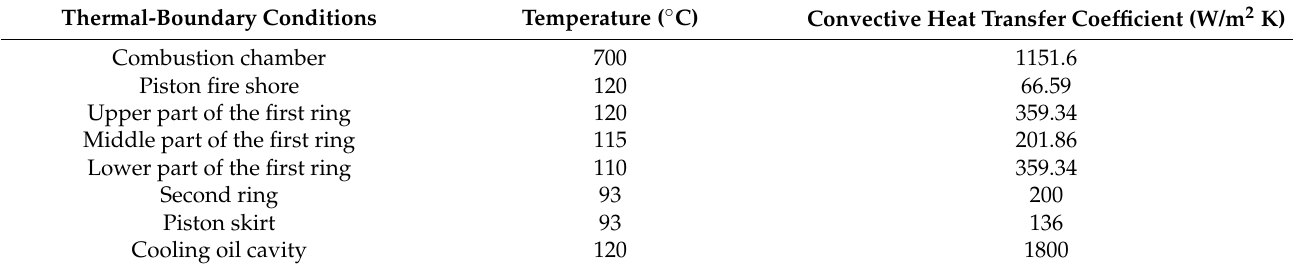
Table 3. Thermal-boundary conditions of the different elements.